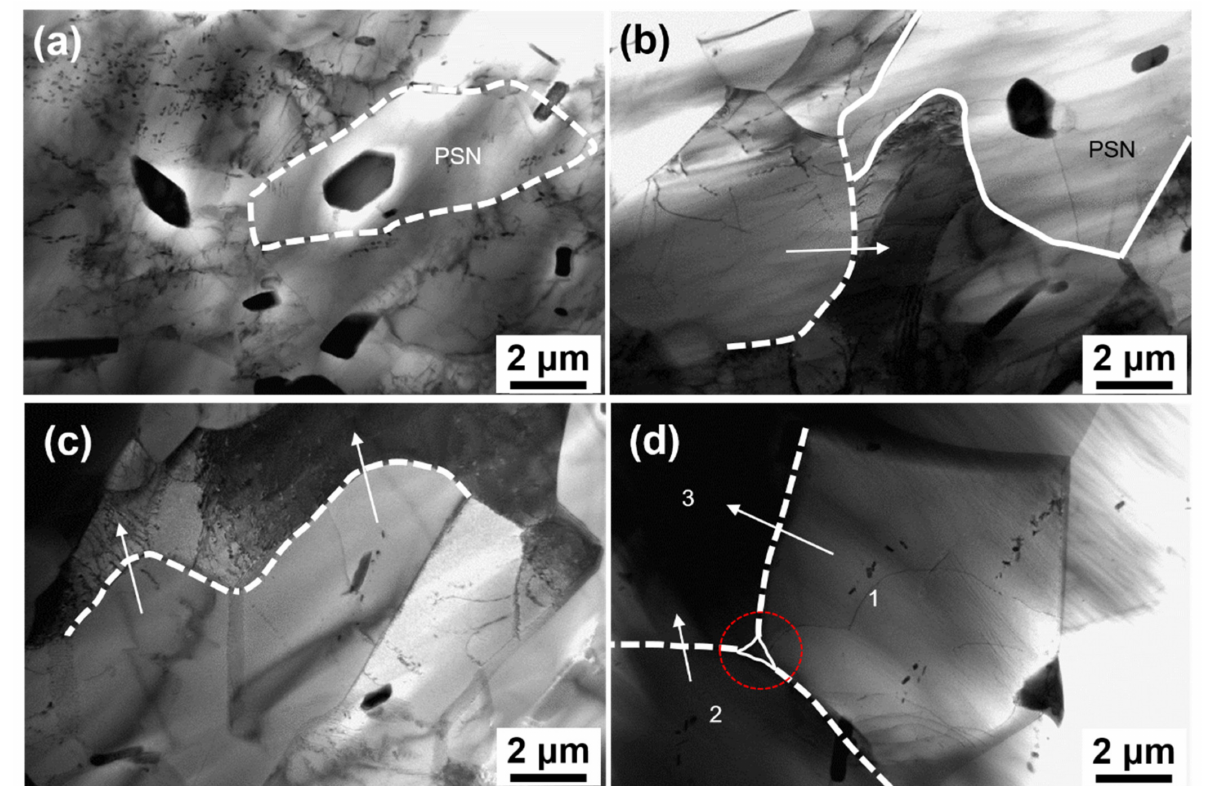
Figure 9. TEM images of DRX microstructure of spray-deposited 7055 aluminum alloy under hot compression conditions of 300 ◦ C/0.001 s − 1 ( a ), 400 ◦ C/0.1 s − 1 ( b ), 450 ◦ C/5 s − 1 ( c ) and 450 ◦ C/0.001 s − 1 ( d